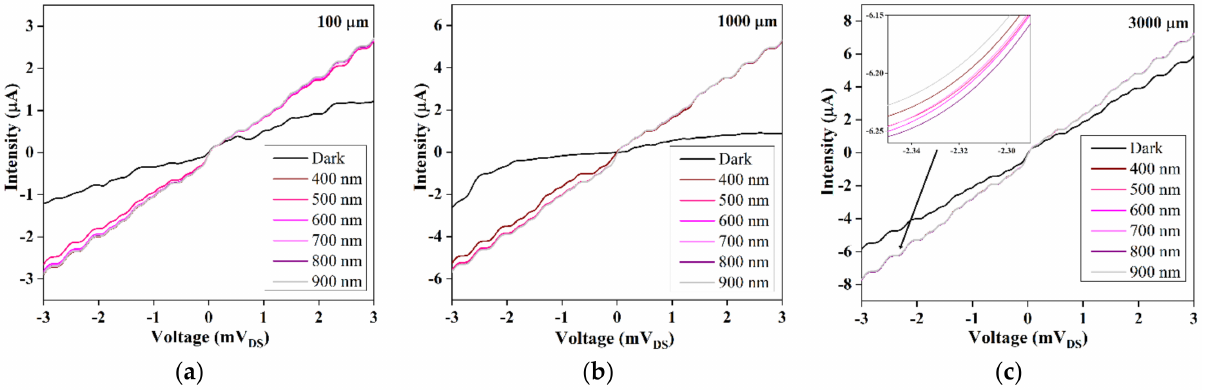
Figure 7. I(V DS ) of the graphene/IDE devices in the dark and under light with different wavelengths (400 to 900 nm). ( a ) 100 µ m; ( b ) 1000 µ m; and ( c ) 3000 µ m. The inset shows a zoom of the curves obtained under continuous